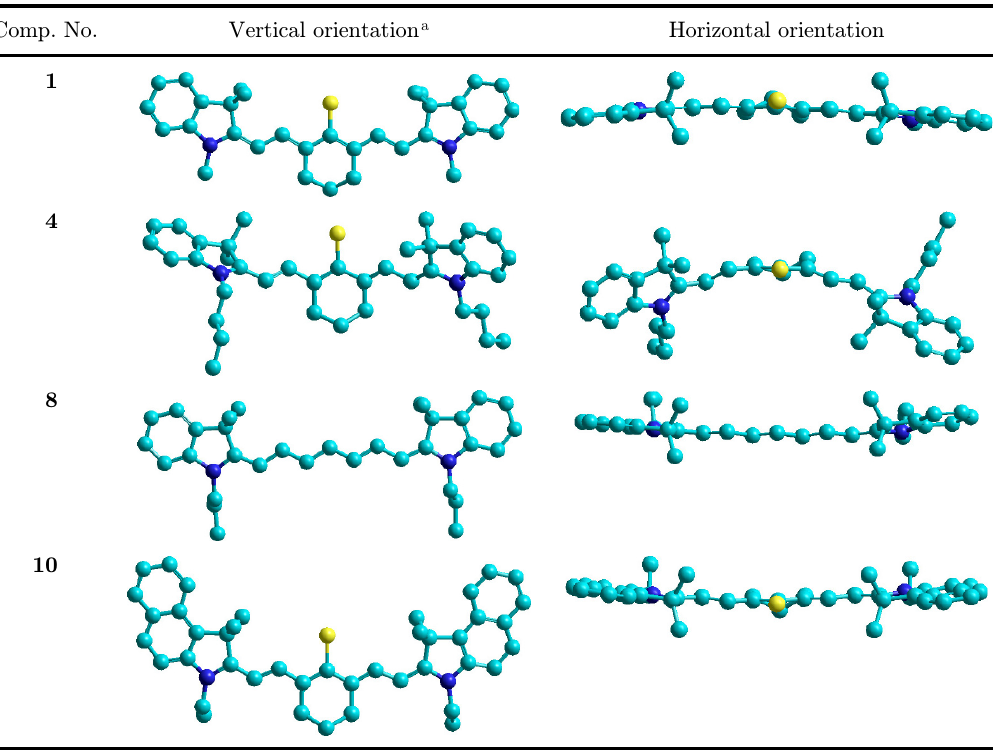
Table 3. Optimized structures of 1 , 4 , 8 , 10